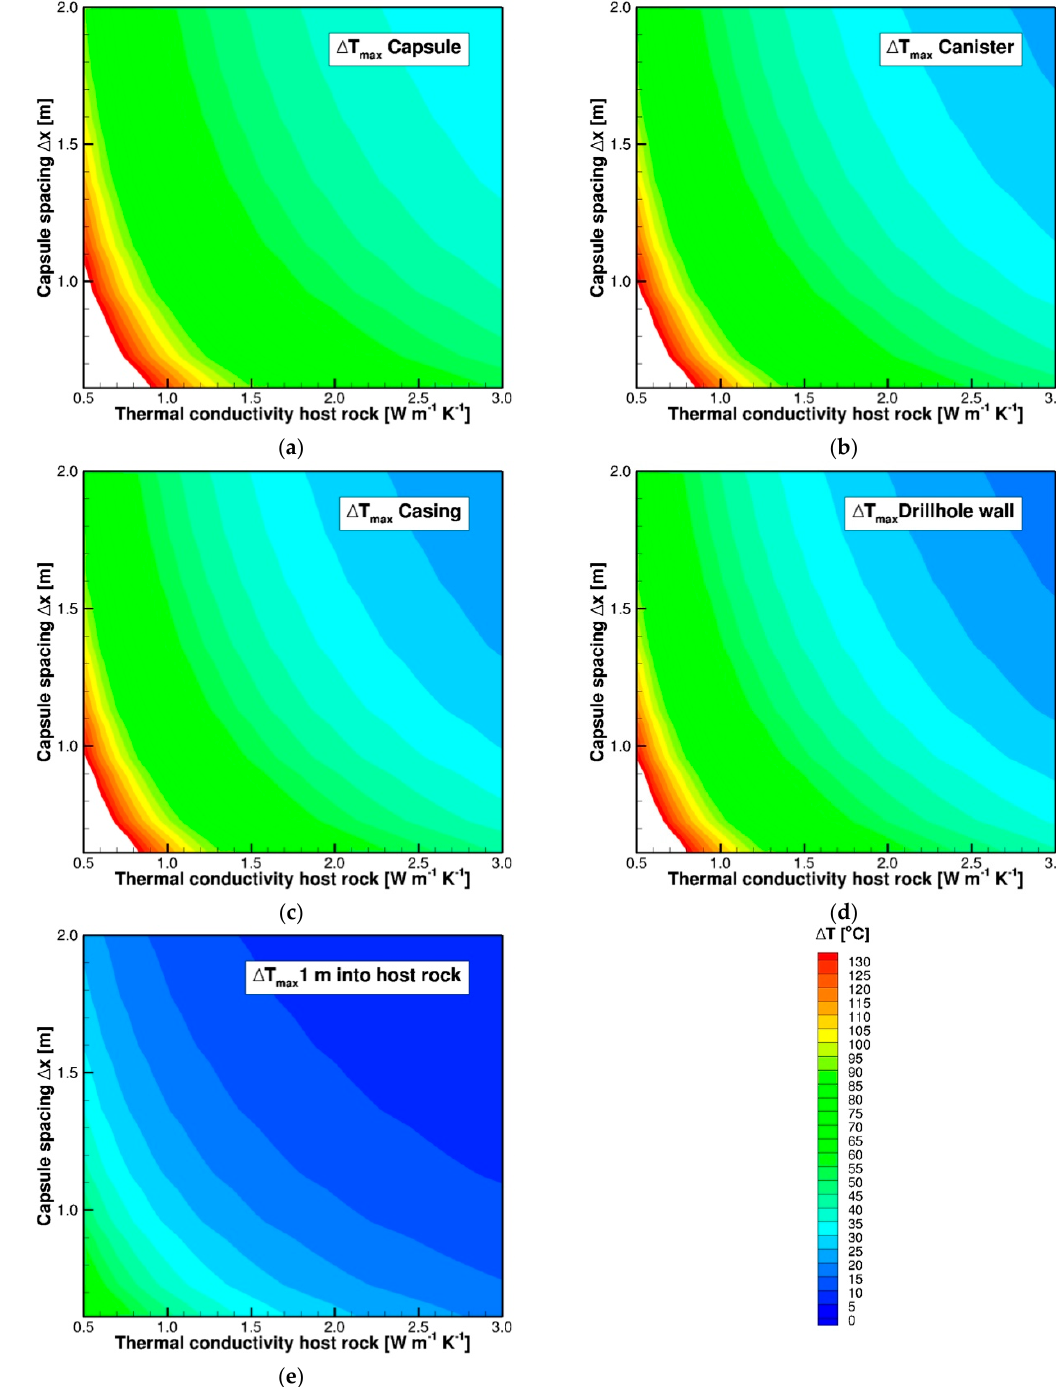
Figure 5. Response surfaces of maximum temperature increase as a function of host-rock thermal conductivity and capsule spacing for a 100 W initial heat output for the following repository components: ( a ) waste capsule; ( b ) canister; ( c ) casing; ( d ) drillhole wall; and ( e ) host rock 1 m from the drillhole wall.